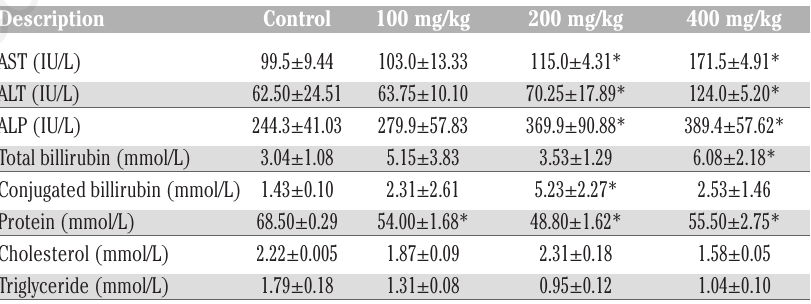
Table 2. Toxicological effect of Solignum ® on biochemical parameters of rats.